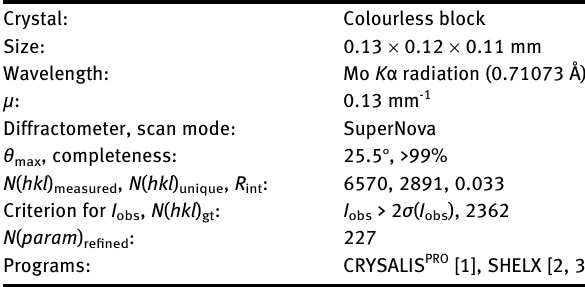
Table 1contains crystallographic dataandTable2containsthe list of the atoms including atomic coordinates and displace- ment parameters.